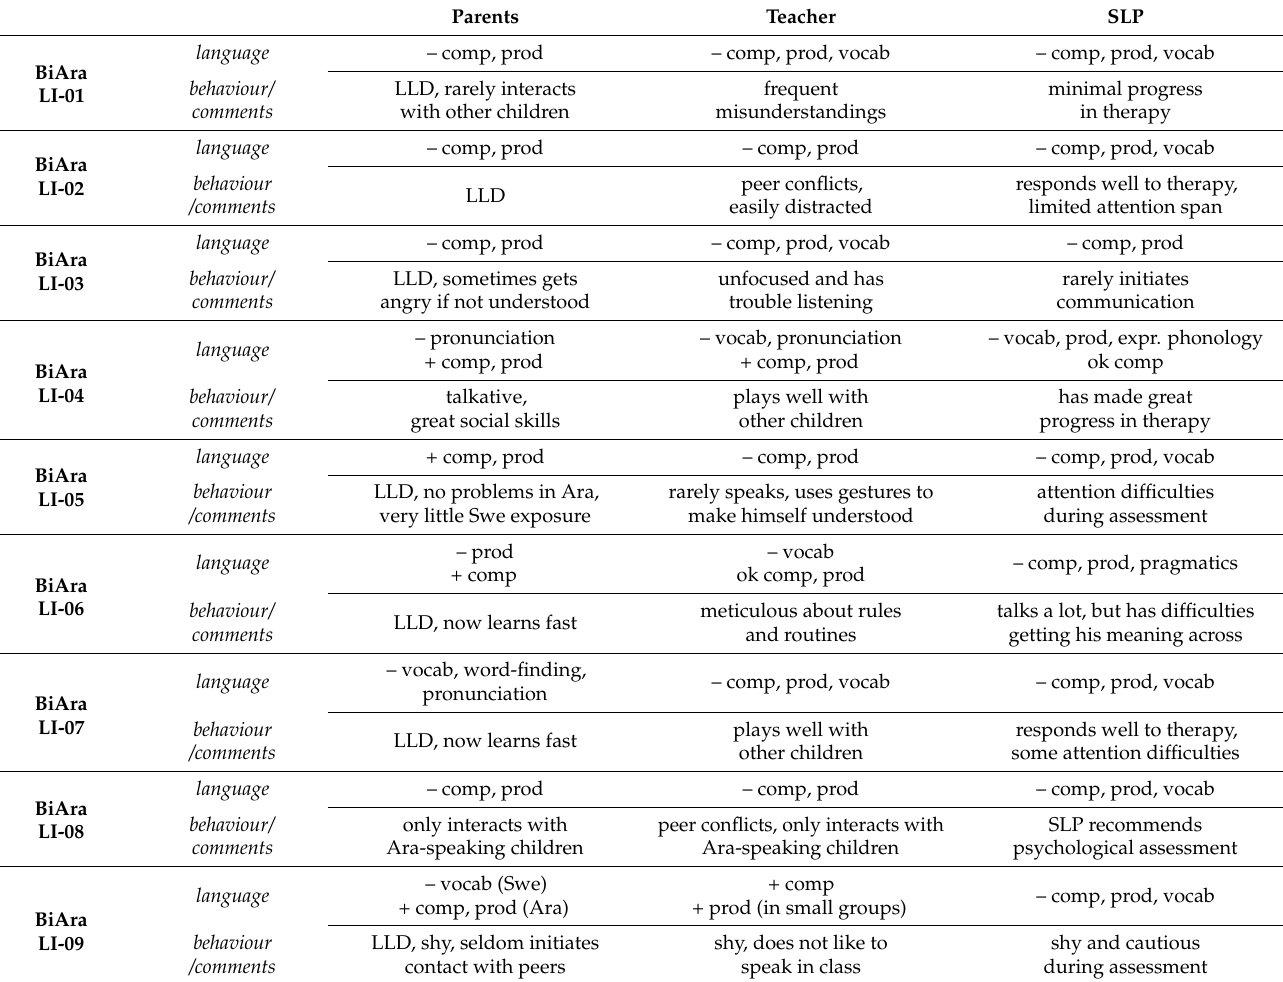
Table A2. Language difficulties and behaviour of the DLD children as described by parents, teachers, and